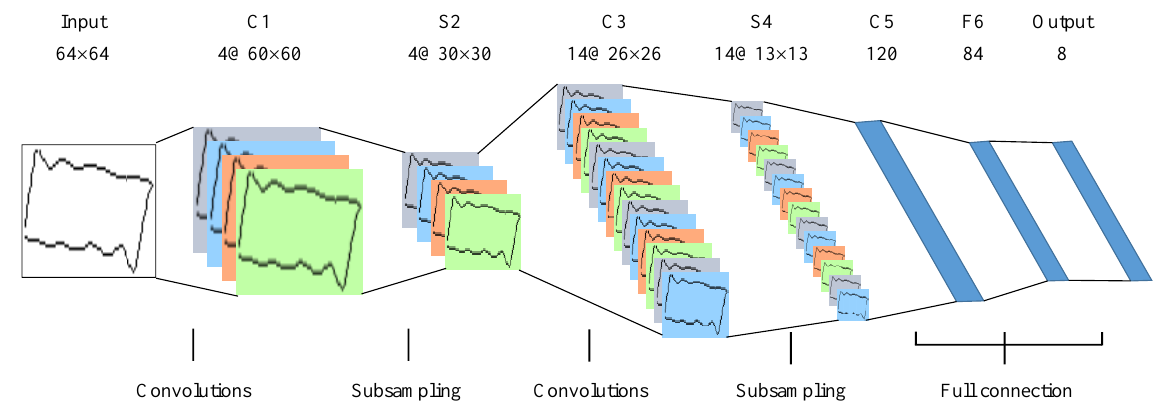
Figure 1—A typical structure of CNN with two feature extraction